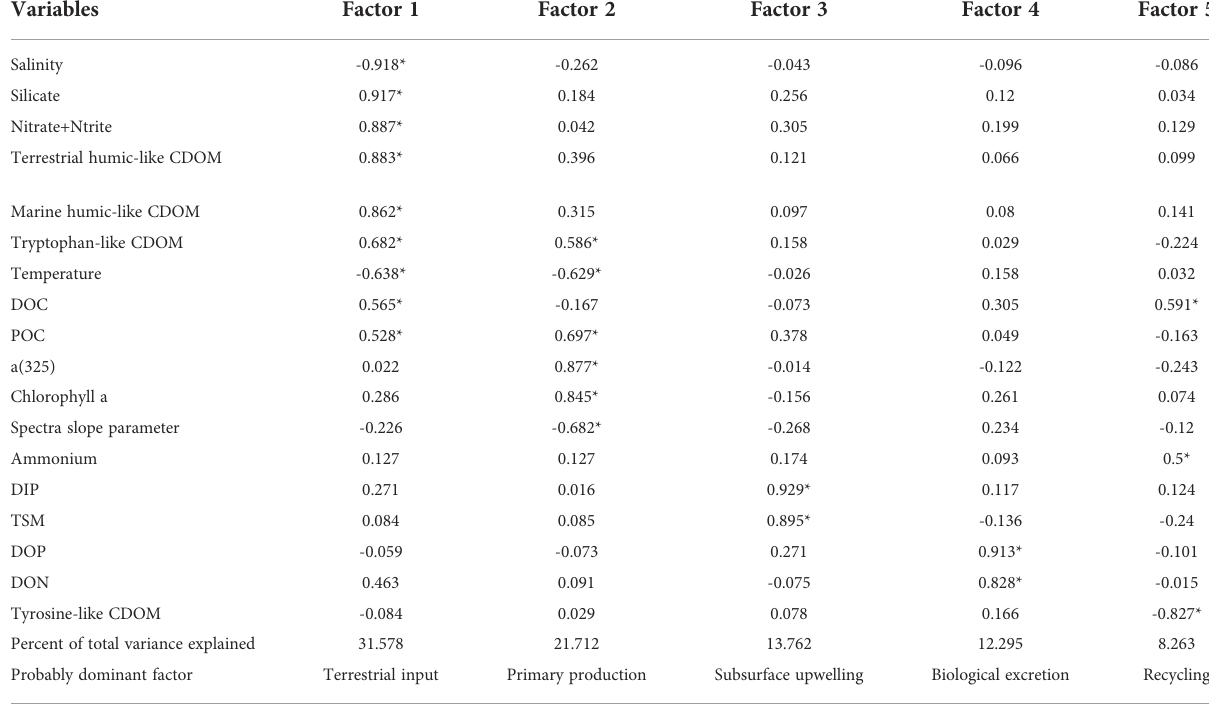
TABLE 2 Factor matrix of hydrological and biogeochemical variables in the TS in early summer